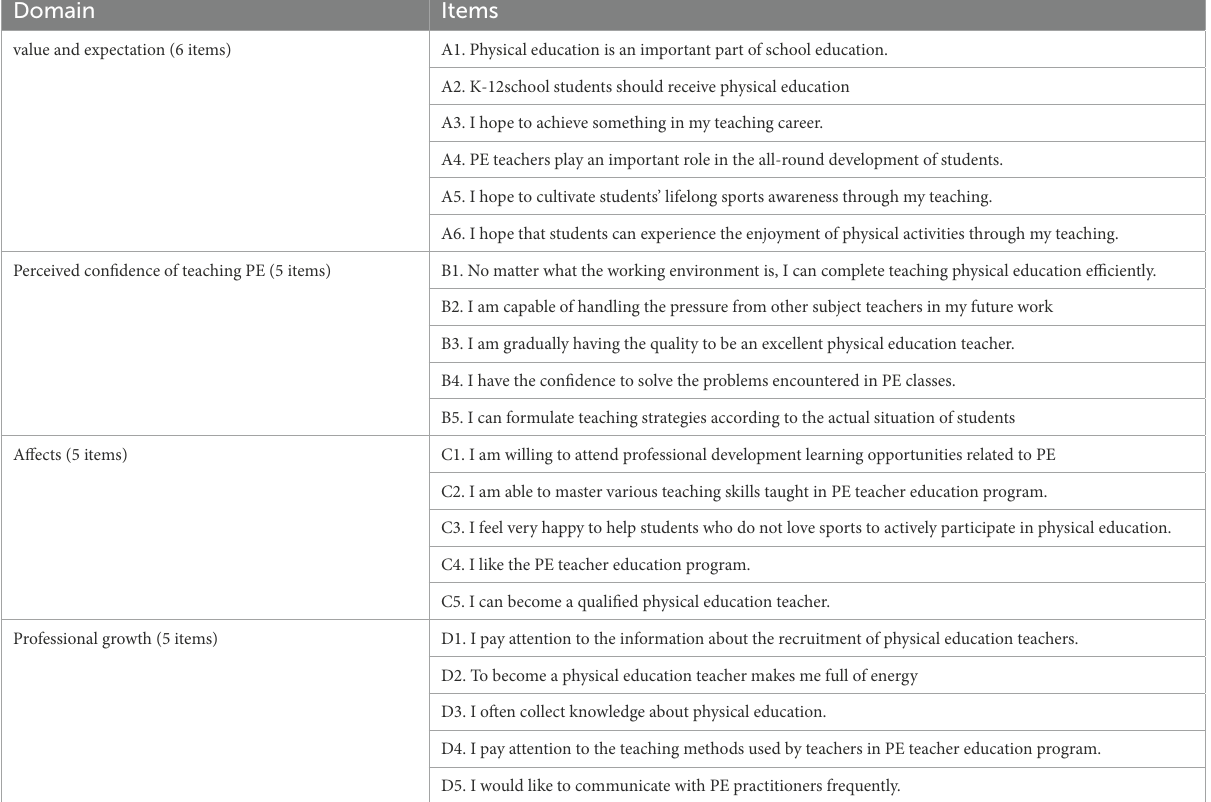
TABLE 1 The structure and items in the original PPET-TI scale with four